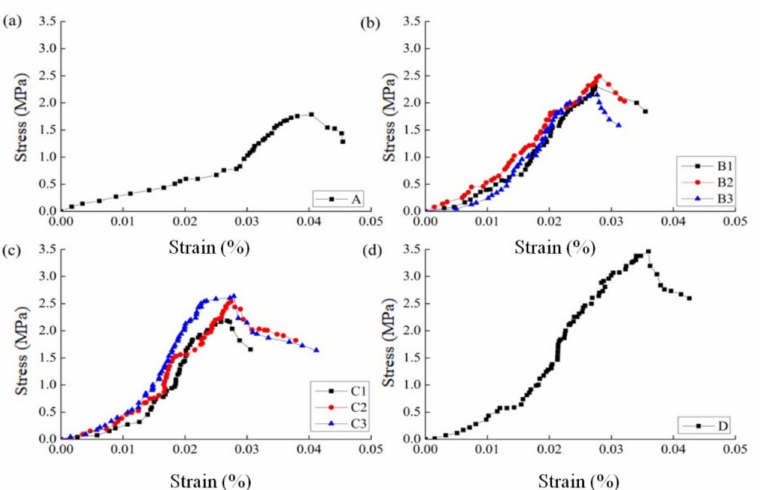
Figure 4. Stress–strain curve of sand solidified with various nutrient solution compositions.Stress- strain of group A ( a ); Stress-strain of group B ( b ); Stress-strain of group C ( c ); Stress-strain of group D ( d